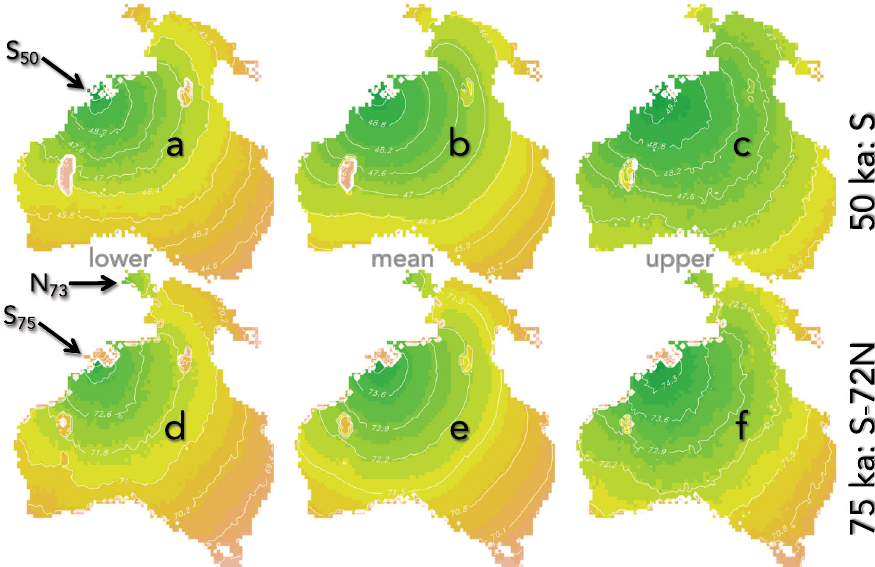
Fig. 4 Pattern of fi rst arrival for the two top-ranked modelled scenarios. Here, entry is via the southern route (entry points denoted by arrow in a ) at 50 ka (S 50 ; top row, a – c ; ‘ 50 ka: S ’ ), and an initial entry via the southern route at 75 ka (S 75 ) followed by a second entry via the northern route 72 generations (~2000 years) later (N 73 ; bottom row, d – f ; ‘ 75 ka; S-72N ’ ). Shown are the lower- and upper-percentile (95% con fi dence interval; a , c and d , f ) and mean maps ( b and e ) for each scenario based on 100 runs of each model. Note in the 50-ka scenario (top row, a – c ), Tasmania was not peopled within the modelled time frame (300 generations) because Bass Strait was fl ooded during this period (position of Tasmania shown in bottom row). Colours indicate progressively older (green) to younger (pink) dates. All date isohyets are expressed as ky relative to arrival time. See ‘ Methods ’ (cellular- automaton framework) for the source of the map extent for Sahul.